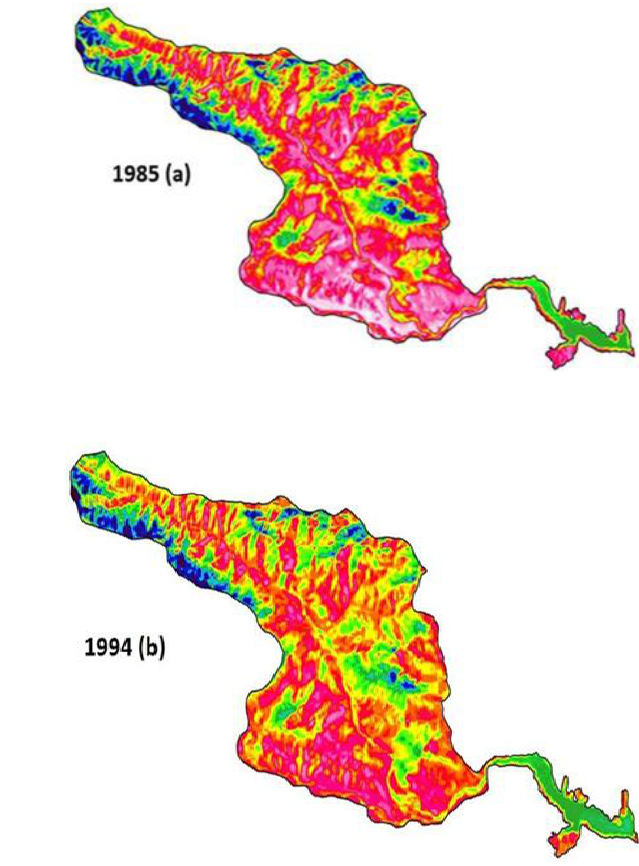
Figure 5. The snow cover (km 2 ) of 1985, 1994, 2010, and 2015. In Fig . 6 the LST time series maps from 1985, 1994, 2010, and 2015 are prepared. LST for Landsat TM5 (1985, 1994, and 2010) data were obtained through band 6 and in Landsat OLI8 was acquired by band 10. It has been identified that LST is increased significantly from 1985 to 2015 but it declined a little in 1994 (Fig. 7). In the study area, LST in 1985, 1994, 2010, and 2015 were respectively 23.27 °C, 23.16 °C, 26.89 °C, and 27.45 °C (Fig. 7). As can be clearly seen, there was an enhancing LST trend as the snow patches have declined from 1984 to 2015 (Fig.